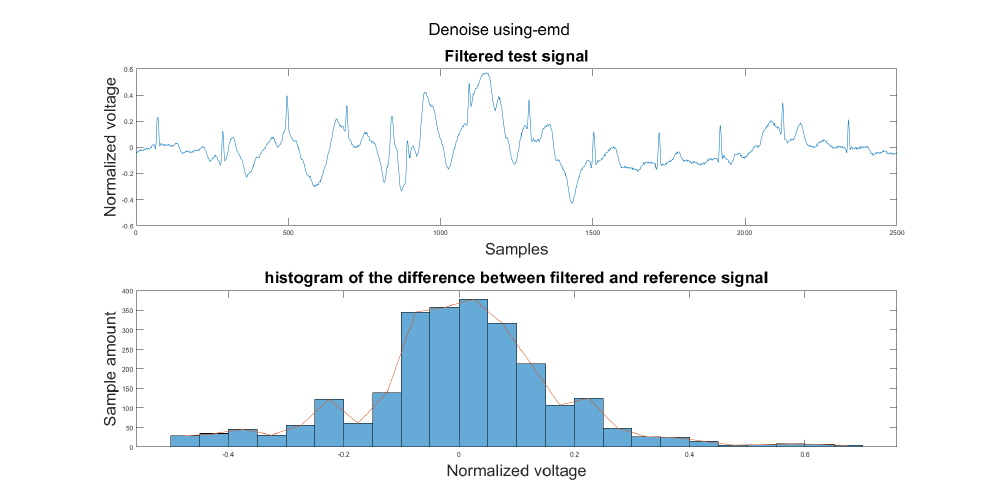
Figure A11. (1) Test signal, (2) histogram of the